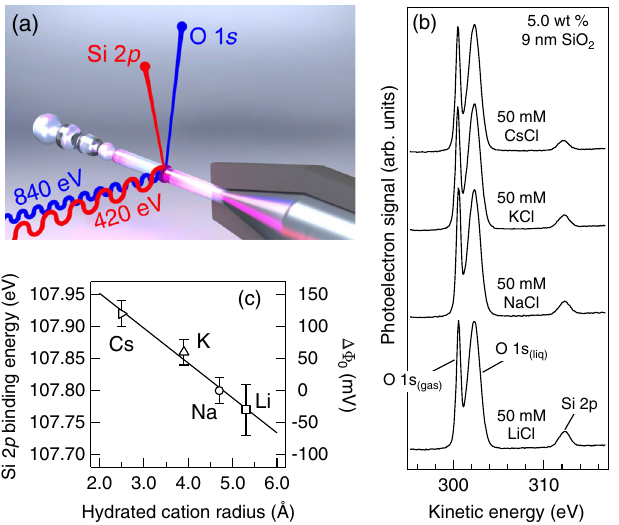
FIG. 2. XPS at the water-silica nanoparticle interface. (a) A liquid microjet delivers a stable free-flowing suspension of colloidal silica inside the measurement chamber of an XPS spectrometer. (b) O 1 s and Si 2 p spectra for 5.0 wt % SiO 2 in 50-mM LiCl, NaCl, KCl, and CsCl electrolytes at p H 10. (c) Measured Si 2 p BE, relative to the vacuum level, as a function of hydrated cation radius [37]. The change in surface potential relative to that in NaCl electrolyte is shown on the right- hand axis. Error bars represent the standard deviation of four repeat measurements.